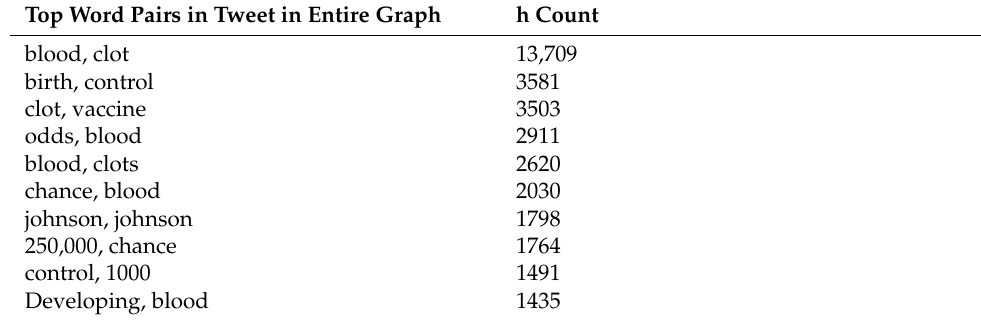
Table 3. Overview of word pairs.